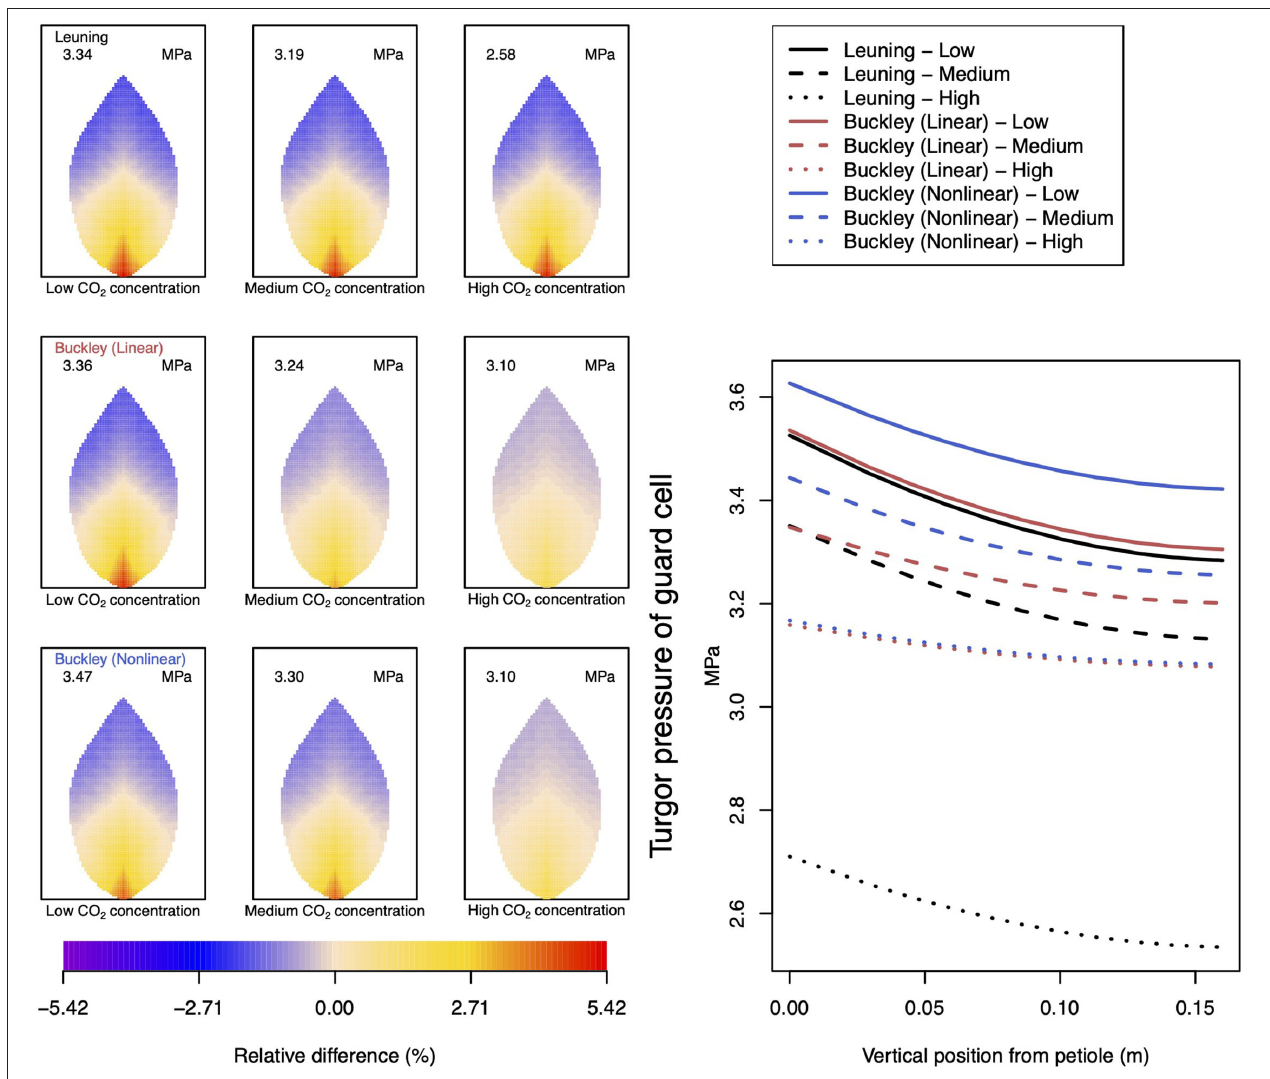
FIGURE 6 | A comparison of predictions of guard cell turgor pressure distributed over the leaf according to the three stomatal conductance models of Leuning (1995) (top row of panels and black lines in right hand figure), linear (Buckley et al., 2003) (middle row of panels and red lines in the right hand figure), and nonlinear (Buckley et al., 2003) (bottom row of panels and blue lines in right hand figure). The 2D maps shown are deviations from leaf-area averages. The leaf-area average values of transpiration rates are given at the top of each panel. The three columns (left-to-right) and line styles (solid, dashed, dotted) show the respective dependencies on the external gas concentration of CO 2 : low (100 ppm), medium (400 ppm), and high concentration (800 ppm). Other model parameter values can be found in Supplementary Information I .